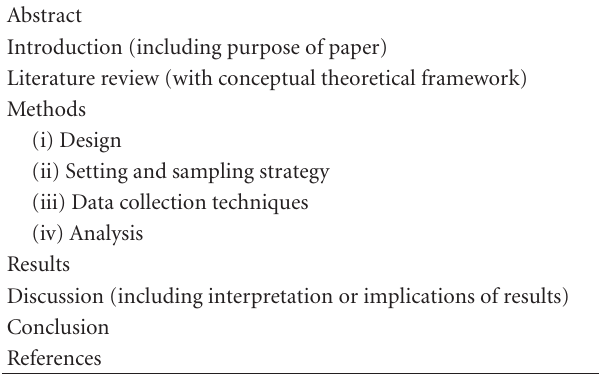
Table 9: Typical format for a journal article